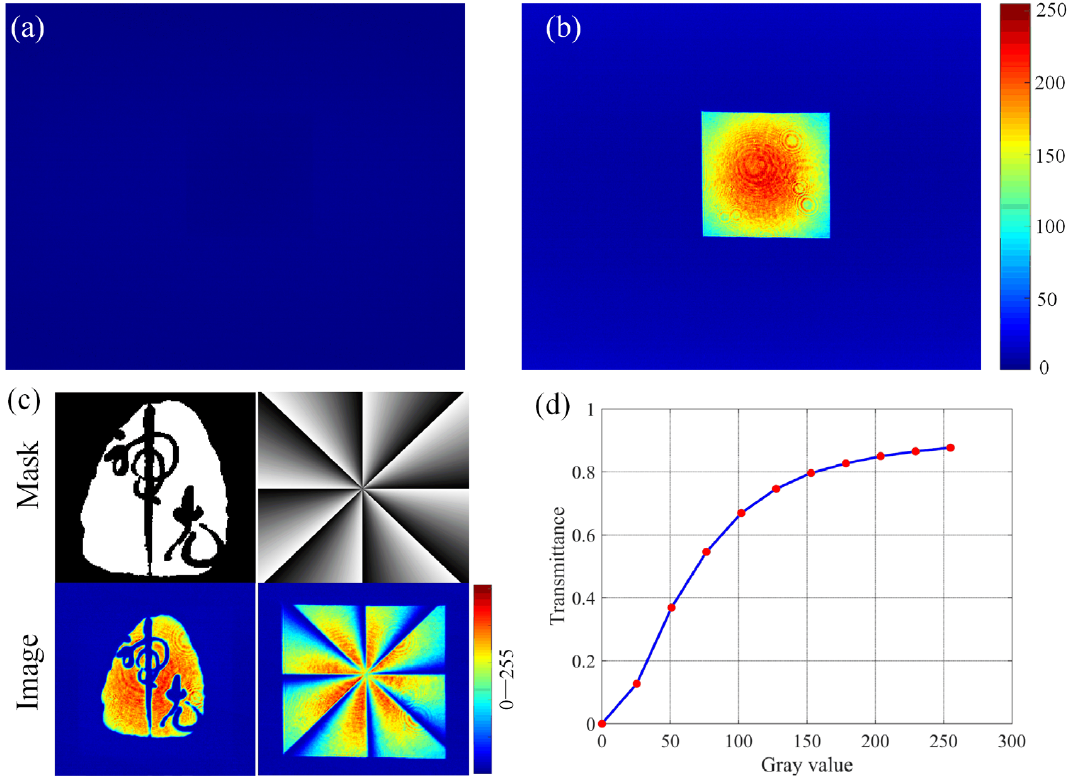
Figure 7. Images output by OASLM in each mode. ( a ) OASLM is in off mode. ( b ) OASLM is in on mode. ( c ) Images under different masks, logos and grayscale. ( d ) The transmittance of OASLM corresponds to the gamma curve of the gray value.